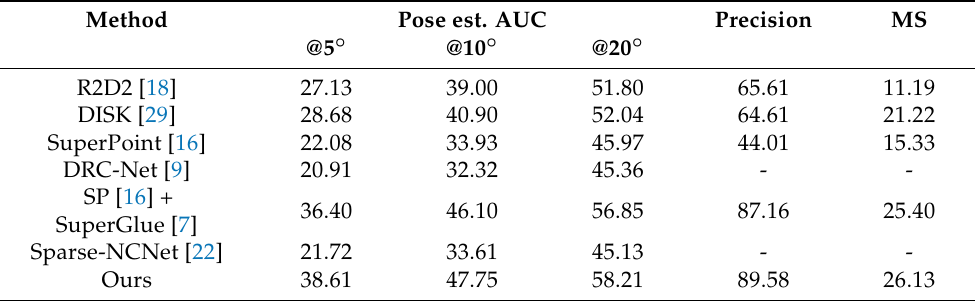
Table 1. Evaluation of State-of-the-art Approaches on MegaDepth.